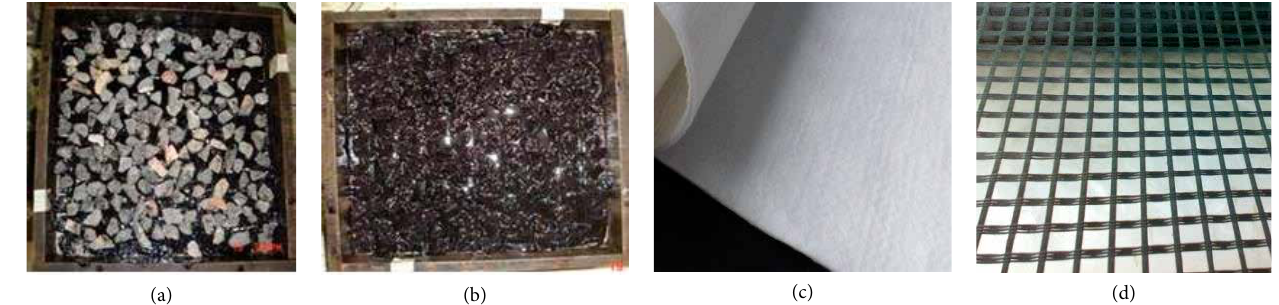
Figure 10: Preparation of specimens (a) asphalt precoating, (b) two oils and one aggregate, (c) the used geotextile, (d) the used glass fiber geogrid.